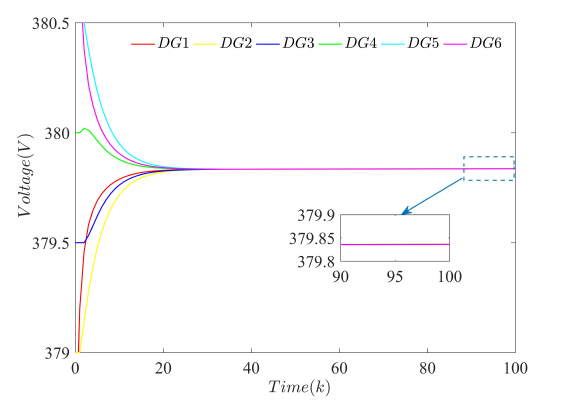
Figure 9. Consensus performance of the DGs using the proposed strategy under the estimation- dependent attack.